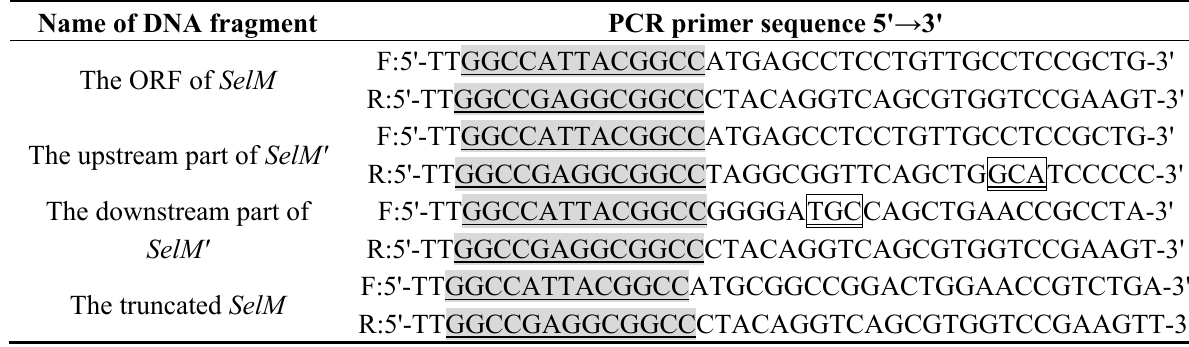
Table 1. The primer sequences used for PCR amplification of SelM and SelM' . Name of DNA